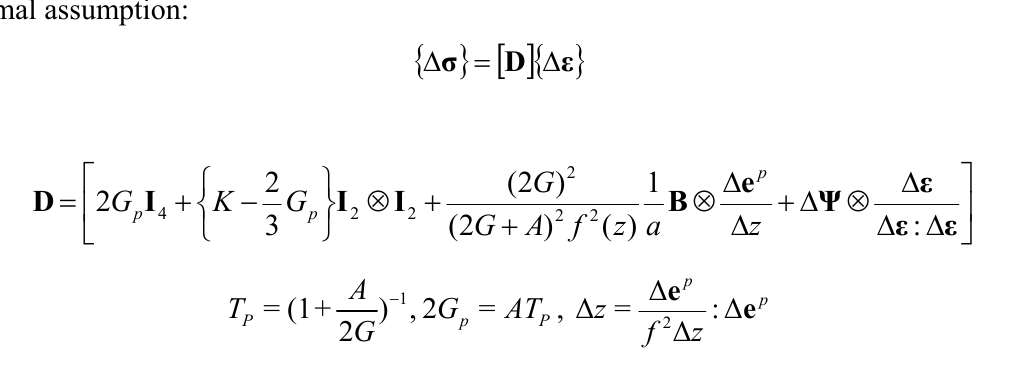
Figure 2. A representative volume element of SMA, h